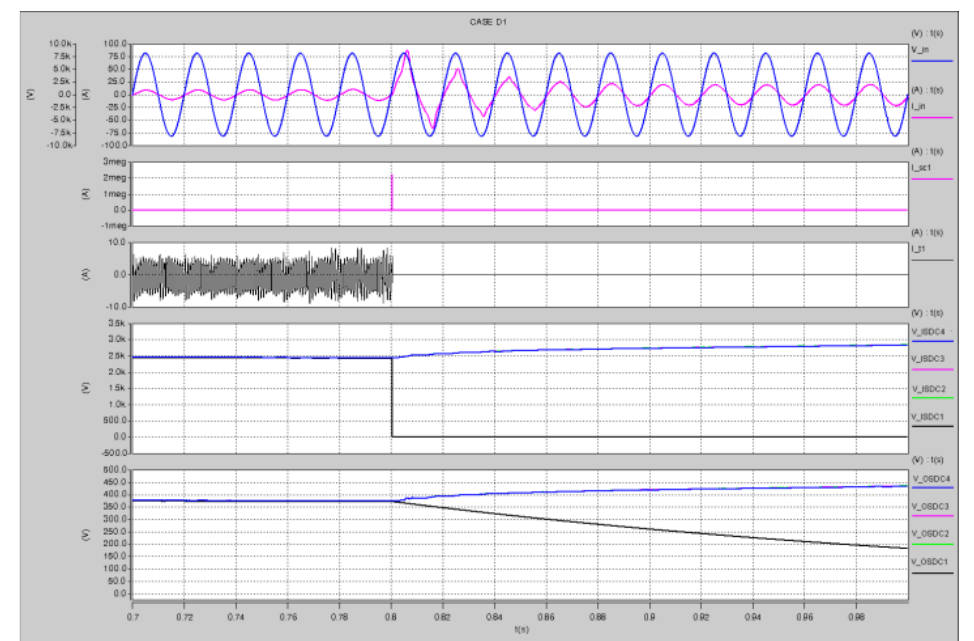
Figure 17. Simulation results of fault